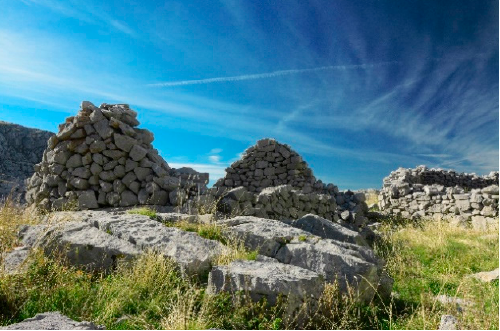
Figure 20. Construction of slate, photo: I. Lakovi ć